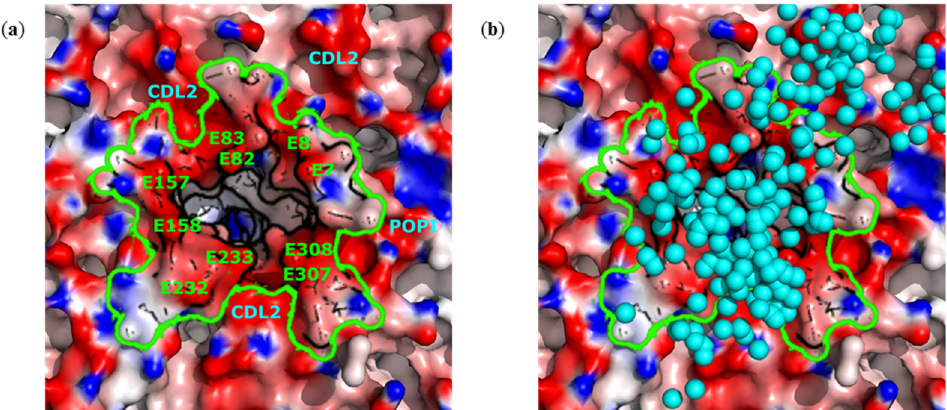
Figure 3. Detailed view of the surface distribution of electrostatic potential from − 100 mV (red) to +100 mV (blue) of the pentameric E protein, embedded into the viral membrane ( a ), and its complexes with ZnPcChol 8+ ( b ). CG beads representing the Zn atom of ZnPcChol 8+ molecules in complexes with the SARS-CoV-2 envelope are shown as cyan spheres. Green line contours the borders of the E protein. Negatively charged surface amino acids of the E protein and negatively charged surrounding lipid molecules are labeled in panel ( a ). The view corresponds to the yellow frame in Figure